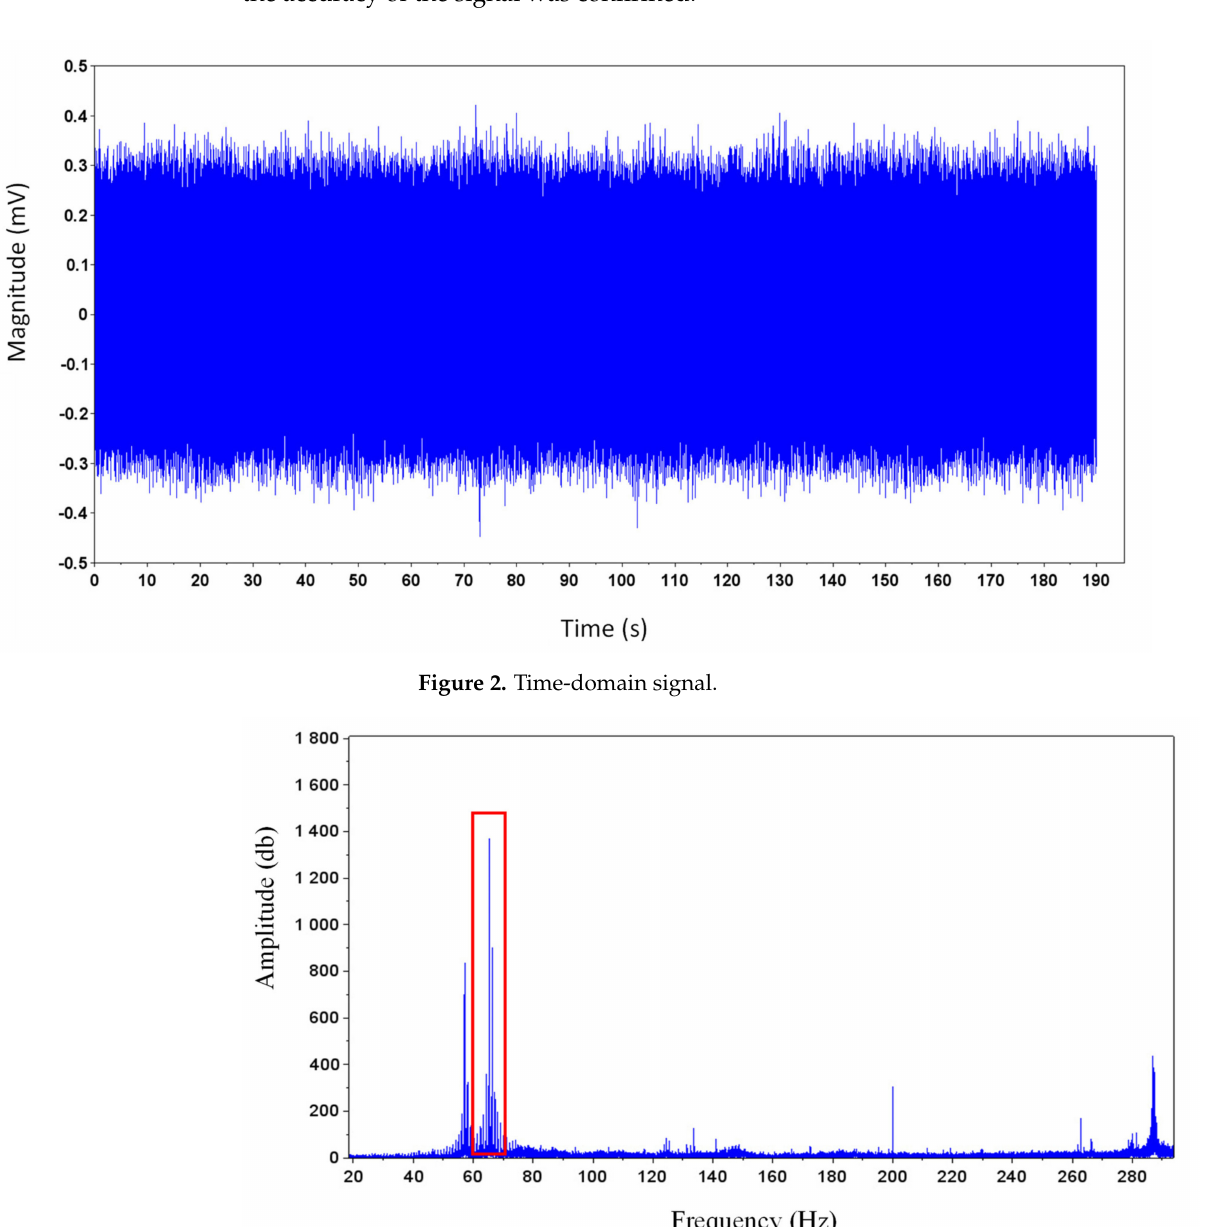
Figure 3. Frequency domain signal speed frequency